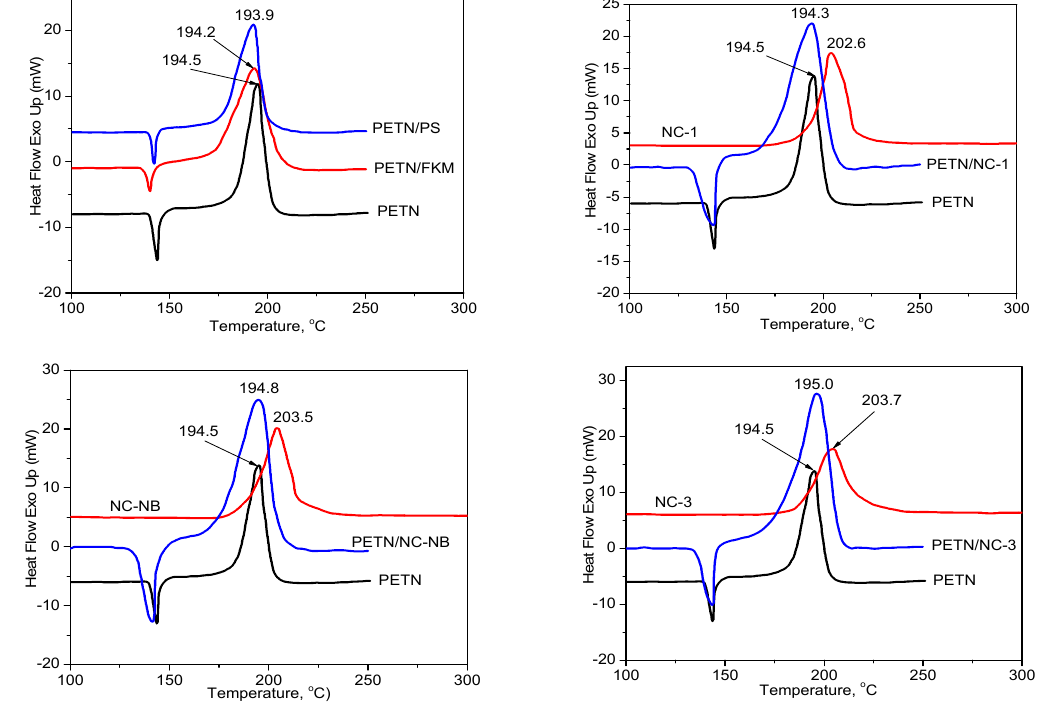
Figure 2. DSC curves of PETN and mixtures based on PETN. Table 3. The chemical compatibility investigated by DSC measurements.